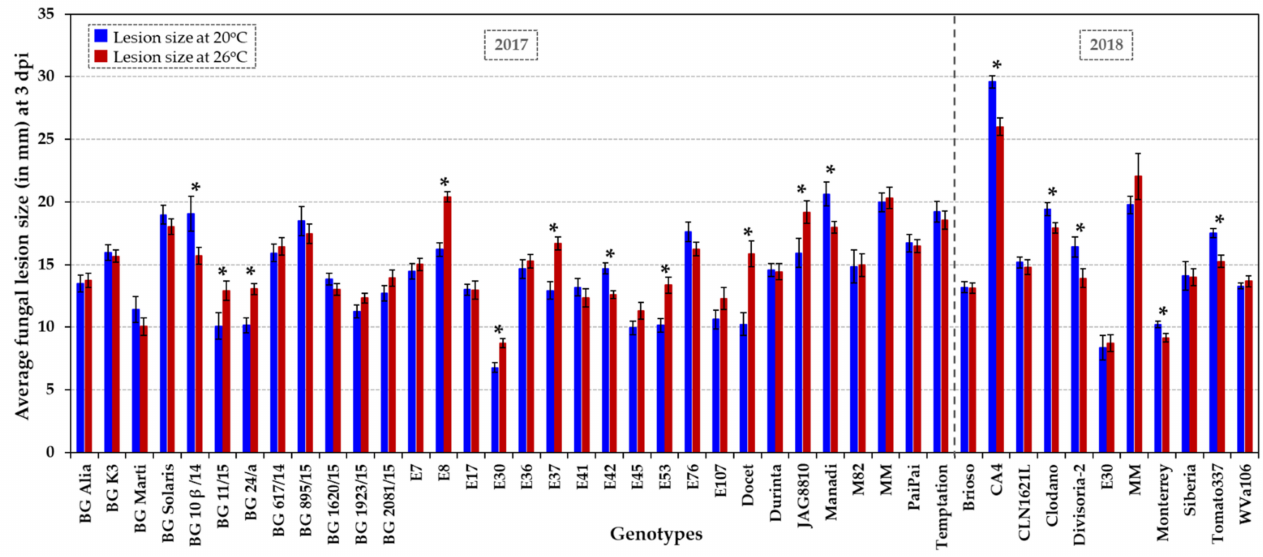
Figure 3. Fungal susceptibility of a collection of 31 HT varieties, six HS accessions (BG Solaris, BG 24/a, CA4, Clodano, E30 and E41) and four control genotypes (JAG8810, Docet, MM and M82). Susceptibility towards wound infection by B. cinerea was assessed at two temperature regimes, at normal (20 ◦ C) and elevated temperature (26 ◦ C) in two growing seasons (2017 and 2018) for about 860 tomatoes/3,170 lesions in total. The average fungal lesion size (in mm) of 10 fruits per genotype and treatment is presented at 3 dpi at 20 ◦ C (dark blue columns) and 26 ◦ C (dark red columns). The error bars indicate ± SE. An asterisk indicates a significant difference ( p < 0.05) in fungal susceptibility at 20 ◦ C vs. 26 ◦ C for each genotype. Statistical analyses are presented in Figure S4, including the comparison between genotypes at each